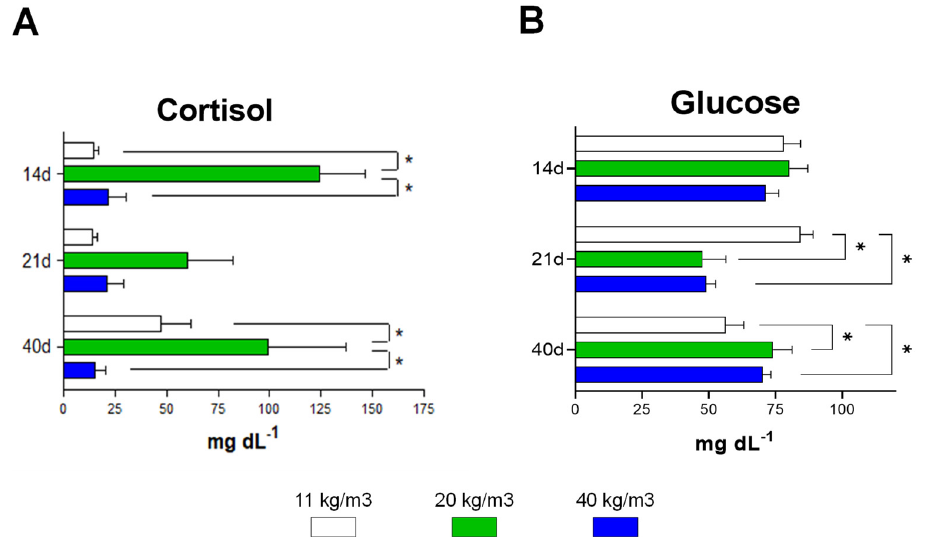
Figure 4. Effect of stocking density plasma biochemical parameters in S. salar post-smolts. Values of cortisol ( A ) and glucose ( B ) plasma biochemical parameters were measured after being cultured at different stocking densities after 14, 21, and 40 days. Bars represent mean ± SD (n = 4, pools of three fishes). Asterisks show significant differences among stocking densities groups. ( p < 0.05, two-way, ANOVA, followed by Tukey’s test).